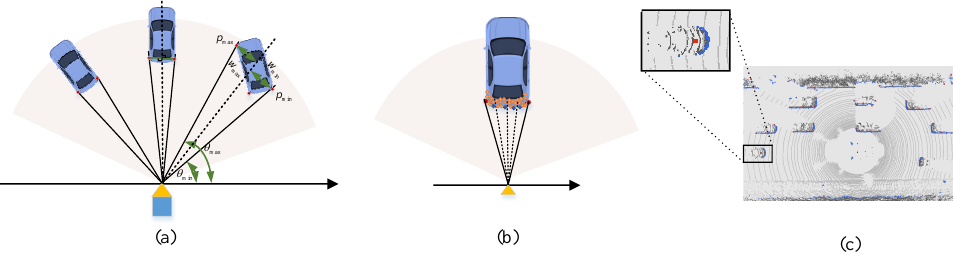
Figure 3. Illustration of the process for the geometric shape classifier. ( a ) shows the processing of endpoints extraction and width calculation, ( b ) shows the step of cluster classifying according to extracted contours, the solid blue points in each segment represent contours. ( c ) shows a real-world traffic scene on the road, there are various clusters on it, the cluster in the black rectangle represents a symmetrical-like